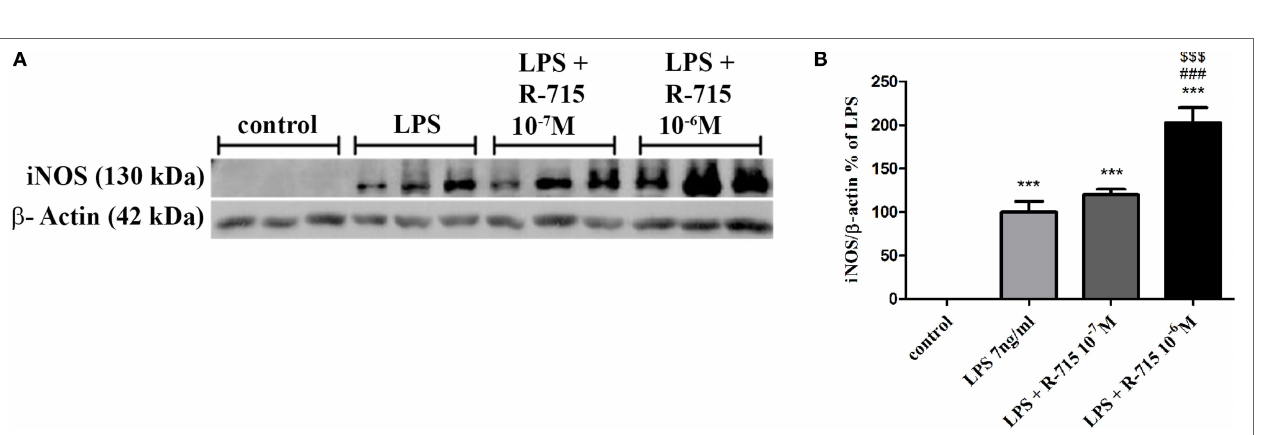
FigUre 4 | effect of the bradykinin B 1 receptor (B 1 r) antagonist on inOs expression in lipopolysaccharide (lPs)-stimulated BV2 cells . Cells were incubated with the B 1 R antagonist R-715 (10 − 7 and 10 − 6 M) and LPS (7 ng/ml) for 24 h. Whole cell lysates (40 µg) were examined by Western blot analysis using anti-iNOS or β -actin antibodies. The results shown here represent three independent experiments (a) . The graph represents the mean ± SEM of three experiments (B) , n = 3. One-way analysis of variance and a Tukey–Kramer Test were used to determine statistical significance; *** P < 0.001 versus the control, ### P < 0.001 versus LPS, and $$$ P < 0.001 versus LPS + R-715 (10 − 7 M).